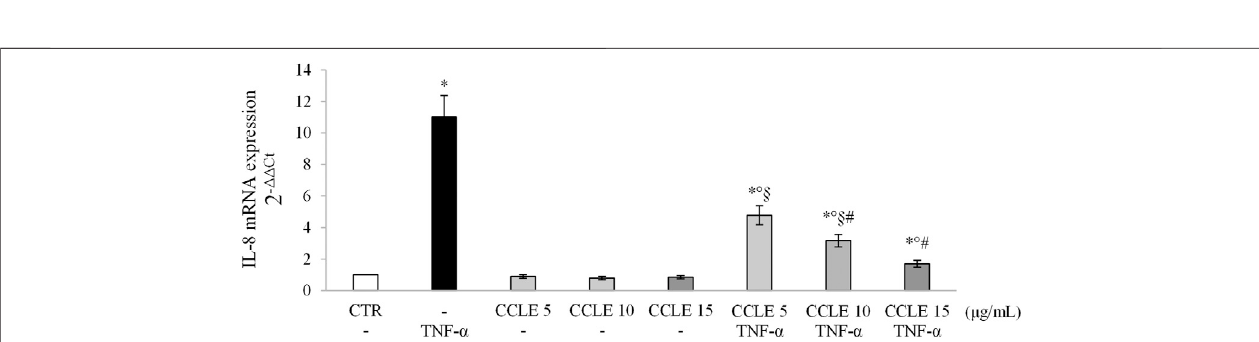
FIGURE3| IL-8geneexpression.TheCaco-2monolayer waspretreated withCCLE (5, 10,and 15 μ g/ml) for24 h,and subsequently exposedto50 ng/mlTNF- α for 6 h. Cultures treated with the vehicles alone were used as controls (CTR). mRNA expression levels were analyzed by real-time PCR and data were expressed as 2 − ΔΔ Ct andnormalizedtoCTR.18SrRNAwasusedashousekeepinggene.Results,derivingfromthreeindependentexperiments,arereportedasmean±SD.* p < 0.05 vs CTR; ° p < .05 vs TNF- α ; § p < .05 vs all doses of CCLE alone; # p < .05 vs lower doses of CCLE + TNF- α .